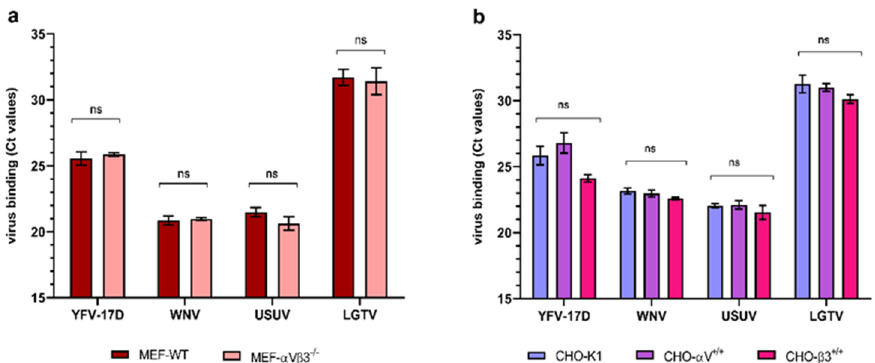
Figure 2. Flavivirus binding to the cell surface of ( a ) MEF-WT and MEF- α V β 3 − / − and ( b ) CHO-K1, CHO- α V +/+ and CHO- β 3 +/+ . Cells were infected with YFV-17D, WNV, USUV or LGTV at a MOI of 10, placed on ice to allow virus binding to the cell surface but no internalization. After 1 h, cells were extensively washed, monolayers harvested and the amount of virus bound to the cell surface was determined by RT-qPCR. Virus binding values are expressed in cycle threshold (Ct) values. Three independent experiments were performed in triplicate each. Bars represent mean Ct values and error bars represent the standard deviation (means ± standard deviation). Statistical analysis: Mann–Whitney test; ns: not significant ( p > 0.05).